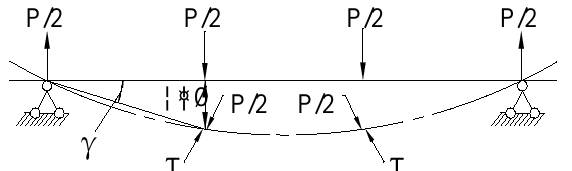
Figure 5: Force Analysis Diagram of Specimen Considering the Shear